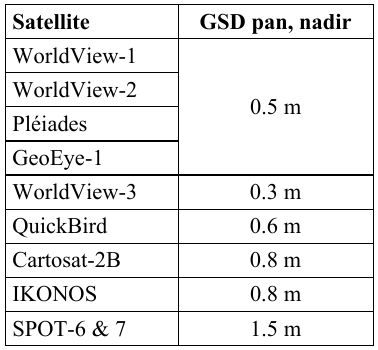
Table 1. GSD of high resolution remote sensing satellites; sources: respective data sheets of the manufacturers/operators In urban areas in particular, the precision of high resolution satellite DEMs falls due to disparities in the stereo image pairs.